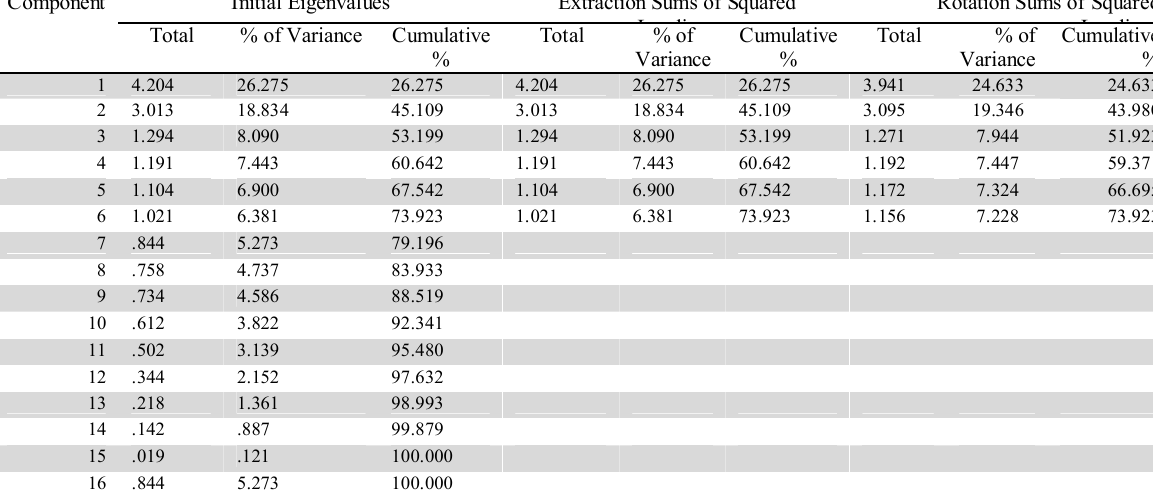
The summary of principal component analysis after rotation